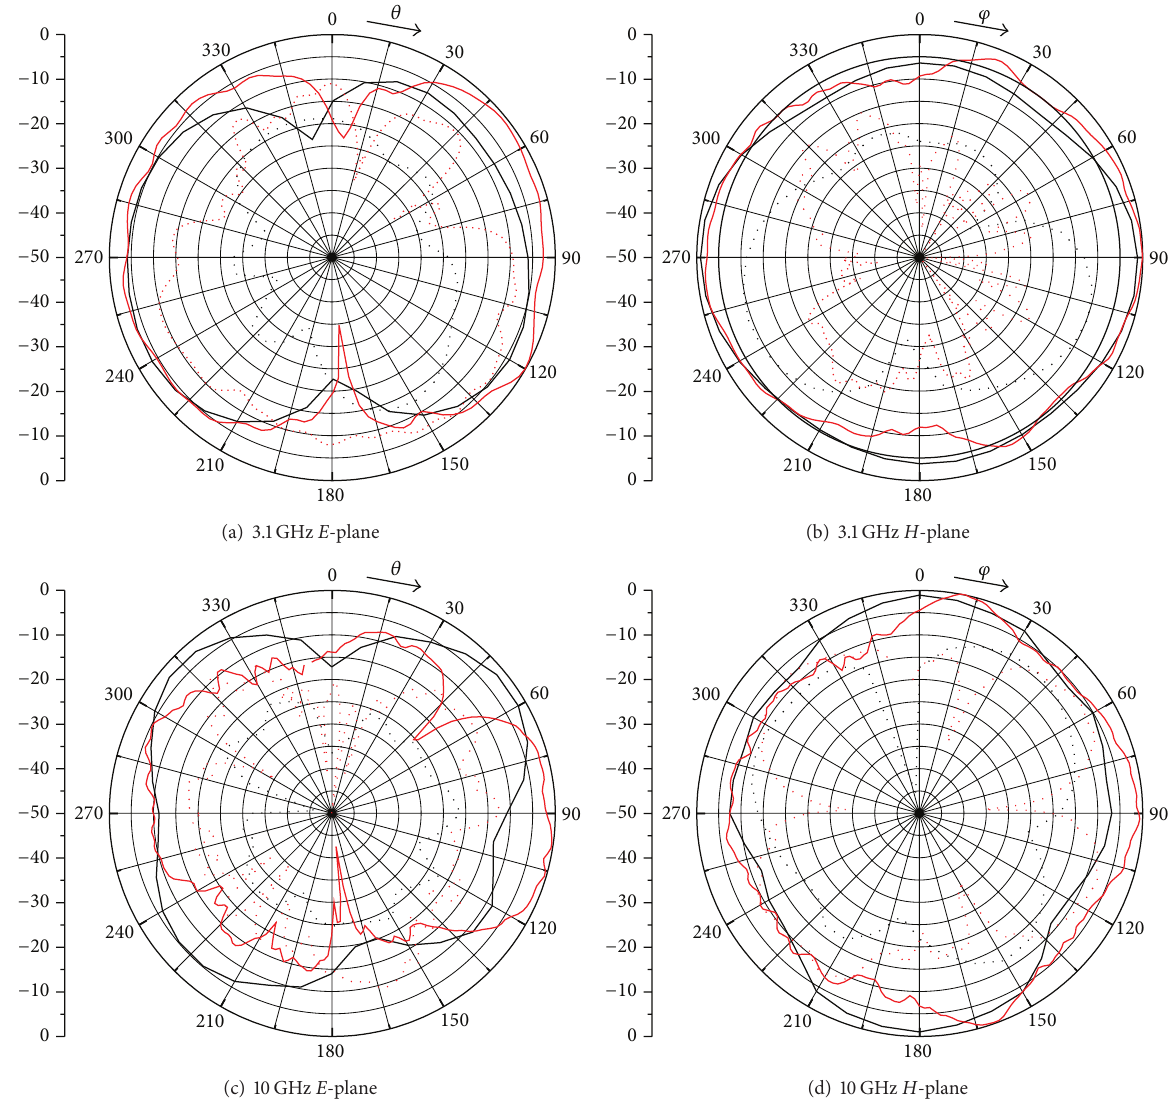
Figure 10: Normalized radiation patterns for the proposed antenna (red solid line: measured copolar polarization, black solid line: simulated copolar polarization, red dash line: measured cross-polarization, and black dash line: simulated